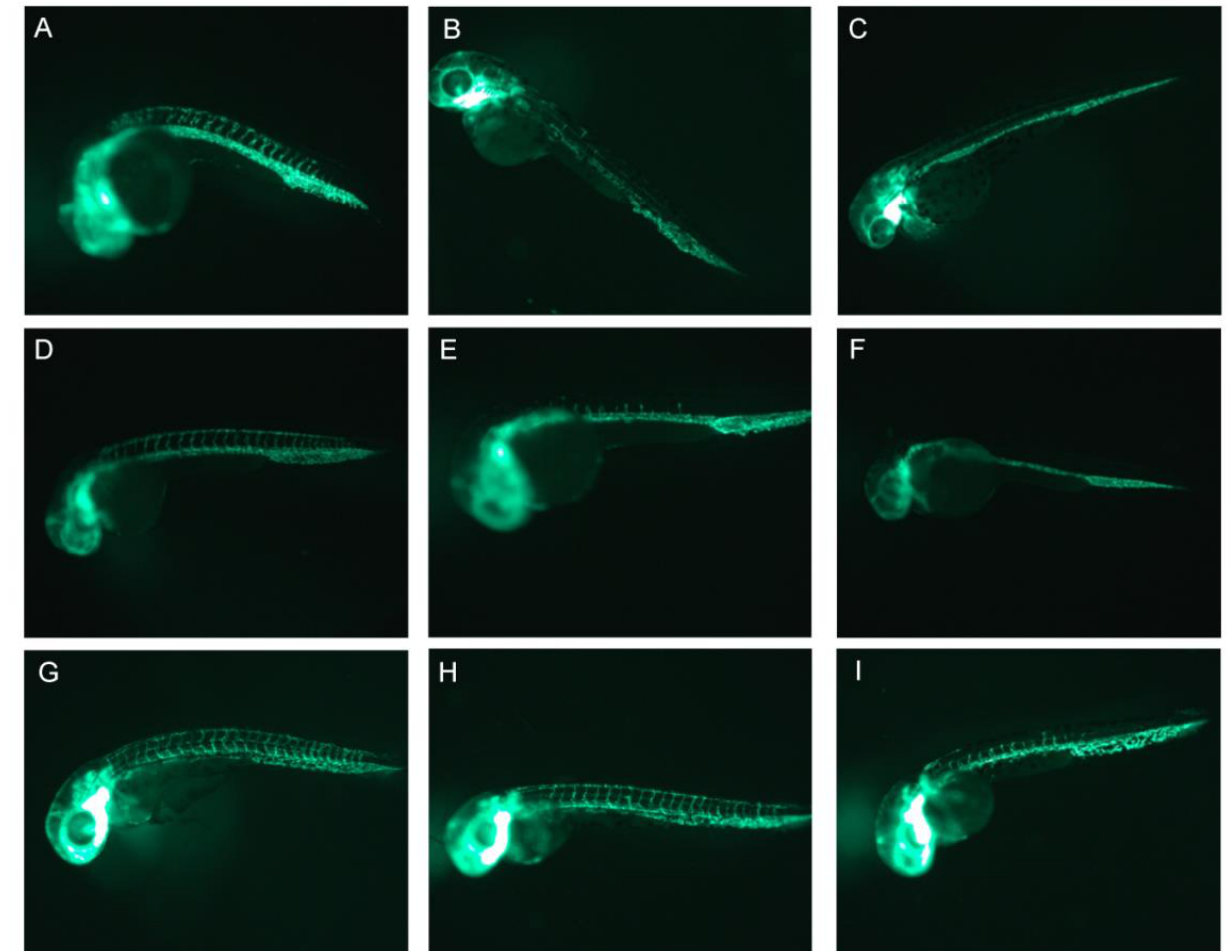
Figure 3. The anti-angiogenic effect observed in Tg(fli1: EGFP) zebrafish embryos exposed 6 hpf ( B , C ), 12 hpf ( E , F ) and 24 hpf ( H , I ) to sorafenib at 1.16 mg/L (2.5 µM) ( B , E , H ) and 2.32 mg/L (5 µM) ( C , F , I ) vs respective negative controls (6 hpf-( A ), 12 hpf-( D ), 24 hpf-( G )) (24-h exposure; ( A – C ) 63× magnification, ( D – I ) 50× magnification).